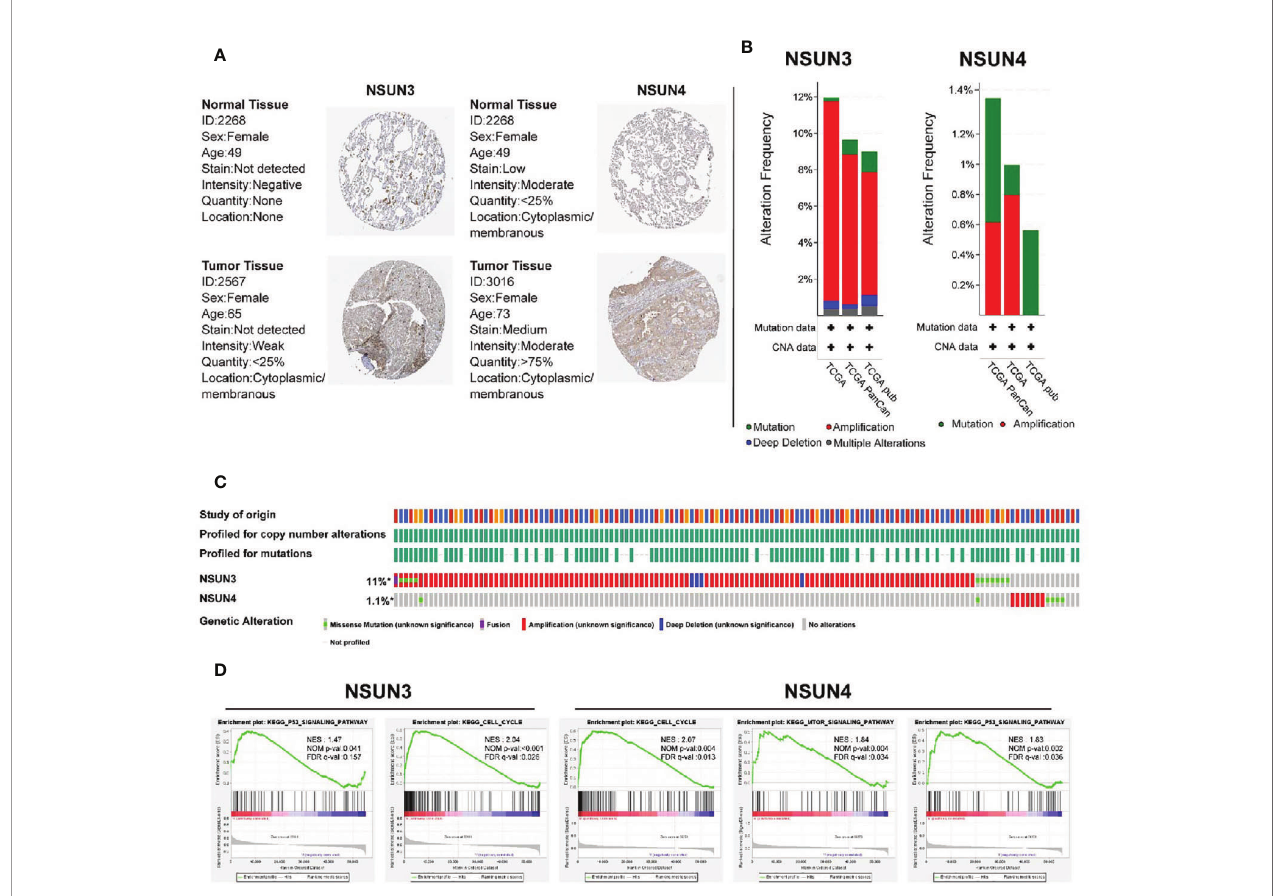
FIGURE 6 | Immunohistochemical analysis (HPA), change frequency analysis (cbiopotal), and gene set enrichment analysis (GSEA) of NSUN3 and NSUN4 in LUSC. (A) The protein expressions of NSUN3 and NSUN4 in LUSC tissues and normal tissues using the HPA. (B, C) The frequency of gene changes in NSUN3 and NSUN4 in LUSC in three independent studies. (D) Enrichment pathway of NSUN3 and NSUN4 high expression group in C2KEGG. NES, normalized enrichment score; NOM, nominal; FDR, false discovery rate. Gene sets with NOM p -val < 0.05 and FDR q -val < 0.25 are considered as signi fi